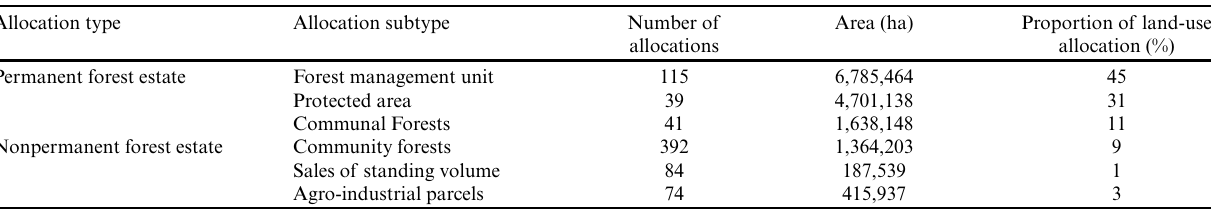
Table 1. Land-use allocation within the national forest estate in Cameroon in 2014. Source: WRI (2014). Allocation